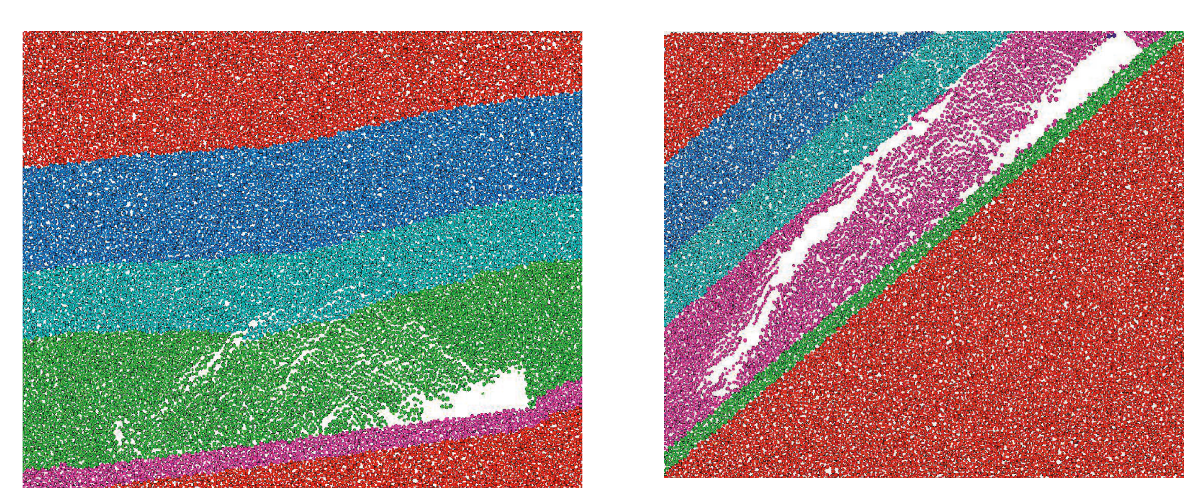
Figure 3: Strike model of the 9-301 working face.